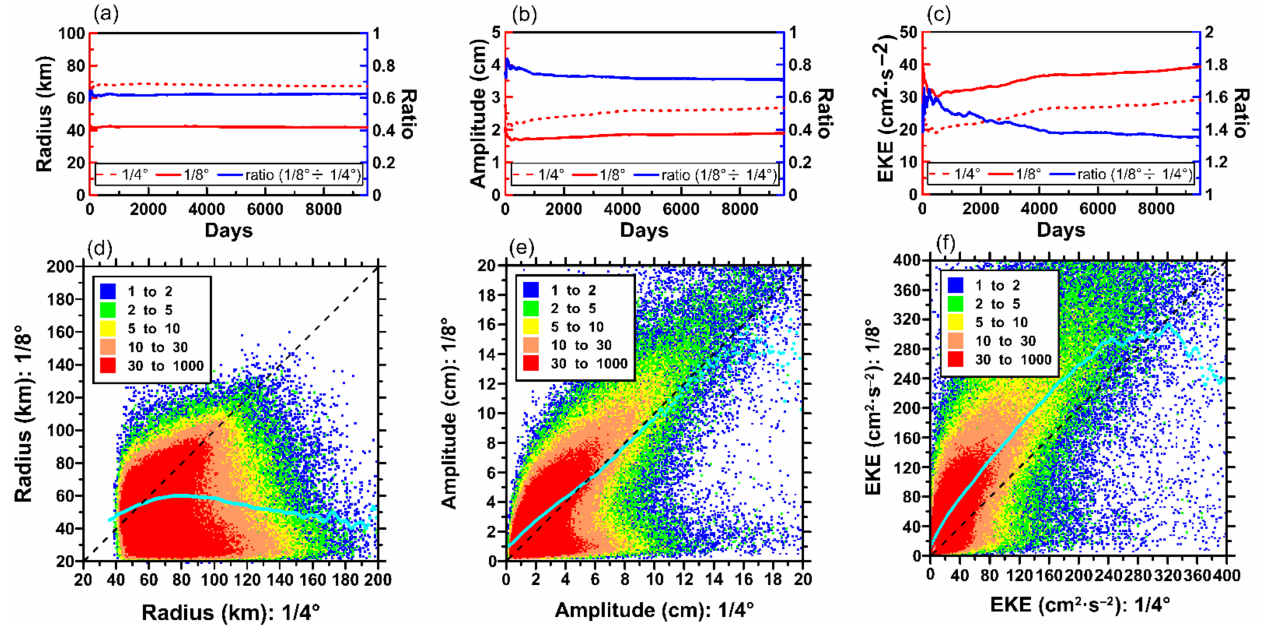
Figure 5. Time series statistics ( a – c ) and ratio scatter diagram ( d – f ) of three parameters in the Mediterranean Sea: ( a , d ) eddy radius; ( b , e ) eddy amplitude; ( c , f ) EKE. In ( a – c ), the red dotted (solid) lines represent the daily average values of 1/4 ◦ (1/8 ◦ all-sat) eddies, corresponding to the red axis in the left, and the solid blue lines represent the ratio of the values of two resolutions, corresponding to the blue axis in the right. In ( d – f ), the abscissa (ordinate) represents the values of 1/4 ◦ (1/8 ◦ ) eddies’ parameter, and the color squares represent the number of eddies that meet the point value, and their ranges are shown in the legend. The cyan lines are the two-dimension fitting of scattered points, and the black dotted lines are